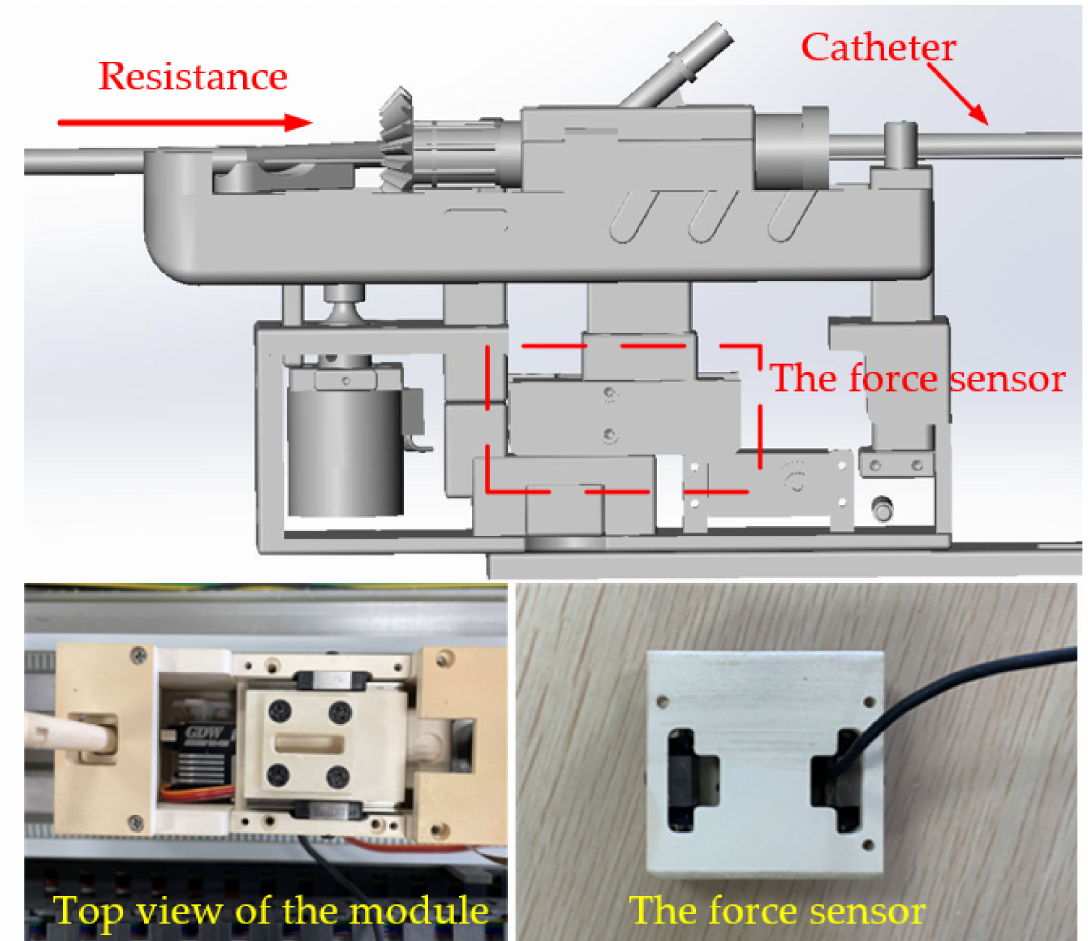
Figure 3. The push module structure